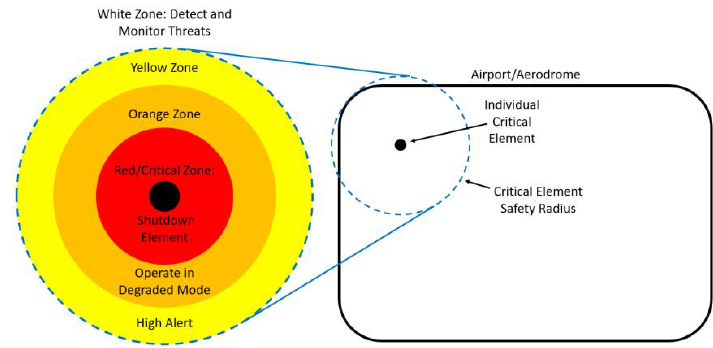
Figure 2. Alert levels and operational modes of a critical asset.